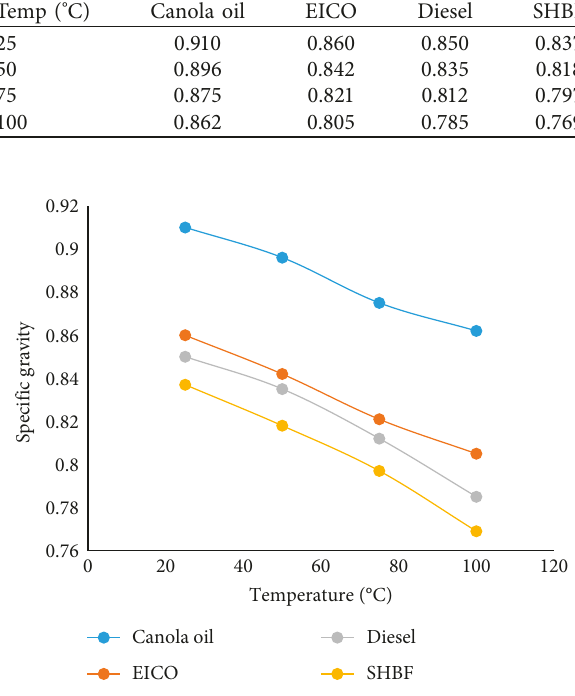
Figure 2: Specific gravity variation with temperature. Table 2: Base fluids’ weight in grams per 50ml density bottle at different